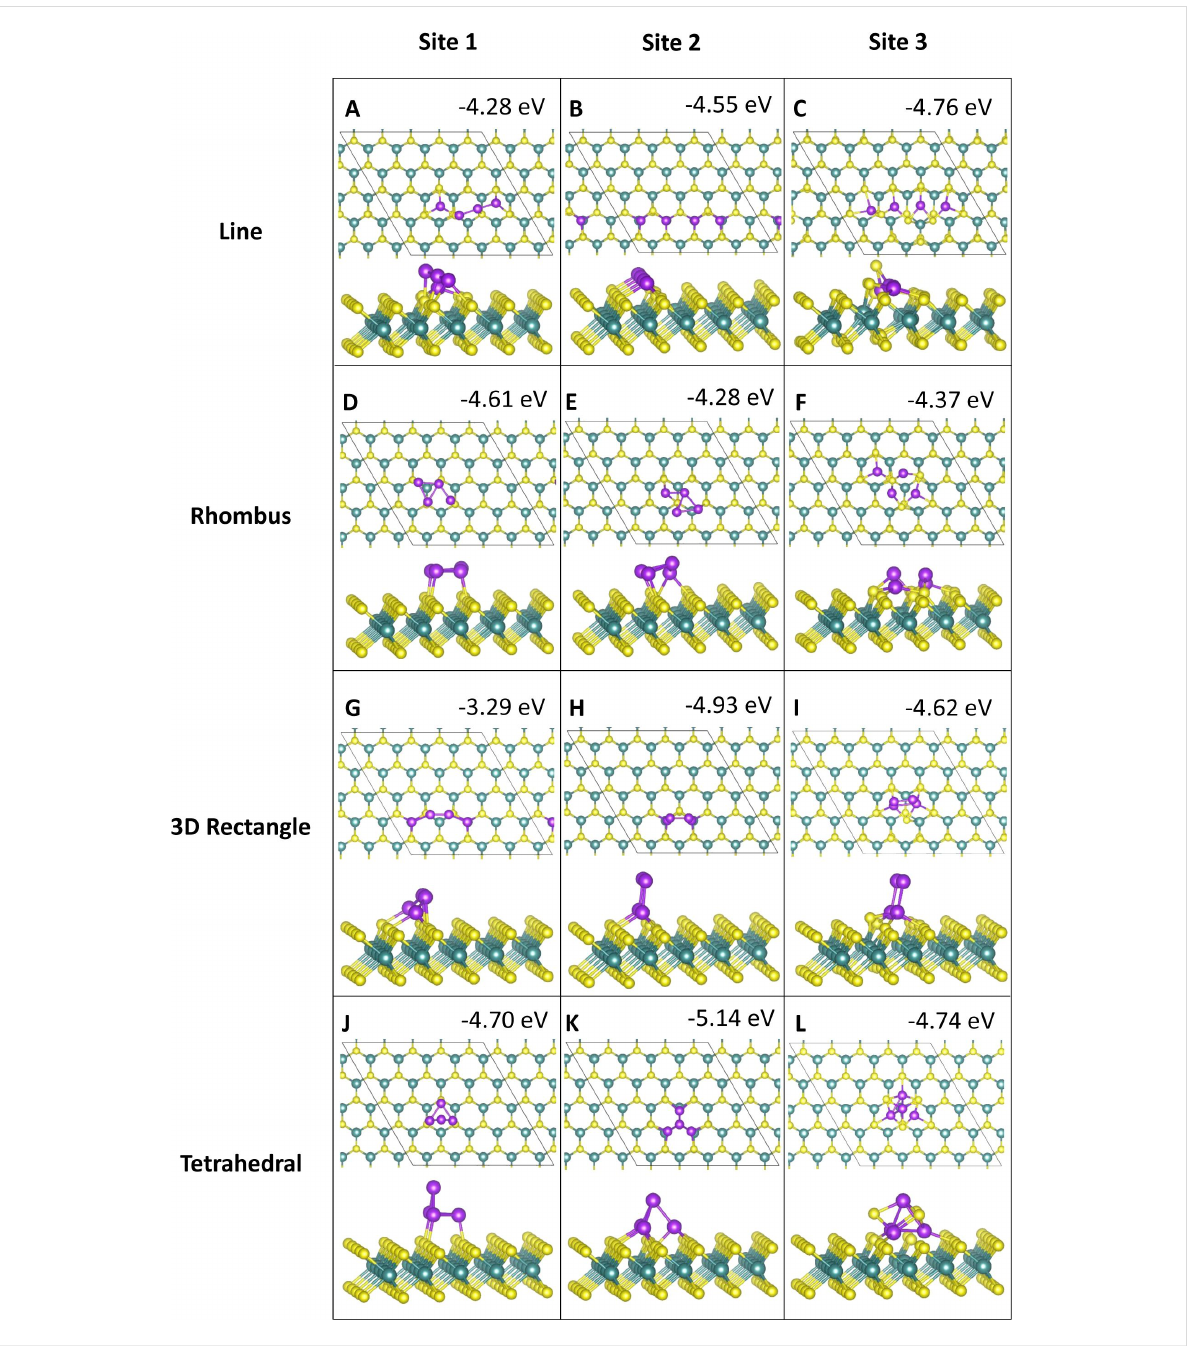
Figure 8: Atomic structure and energies of Ru 4 adsorption modes on perfect MoS 2 .